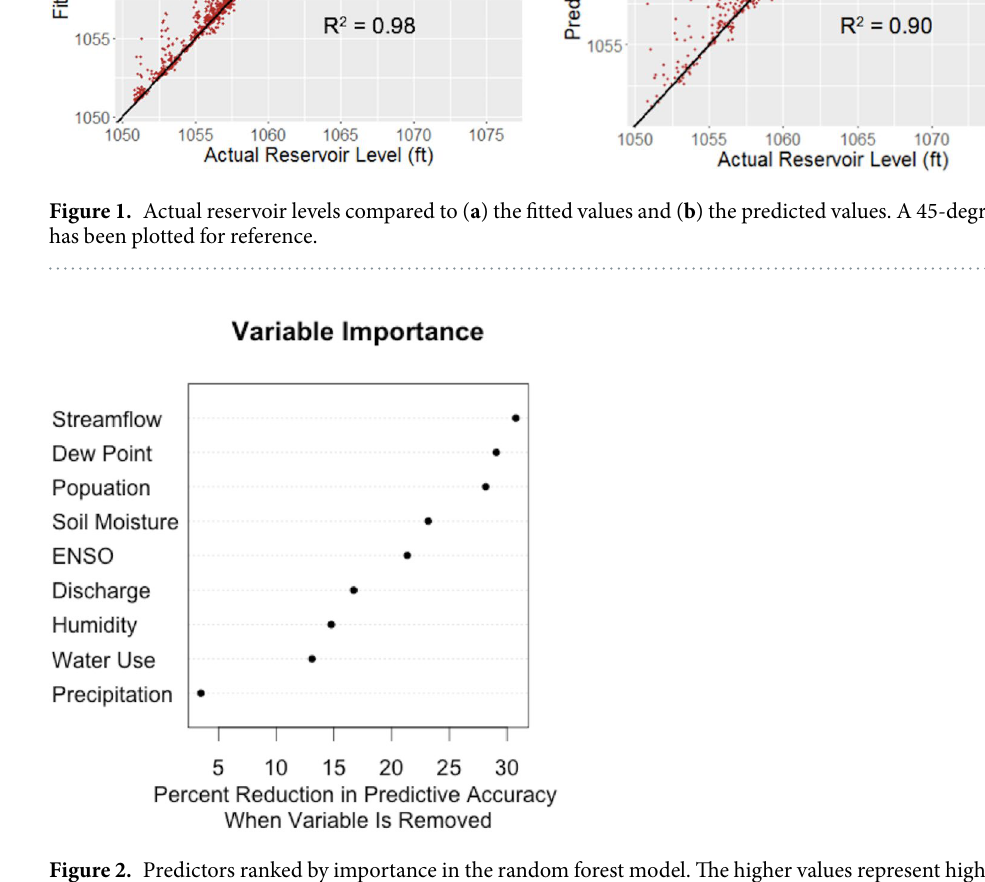
Figure 2. Predictors ranked by importance in the random forest model. The higher values represent higher contribution to predictive